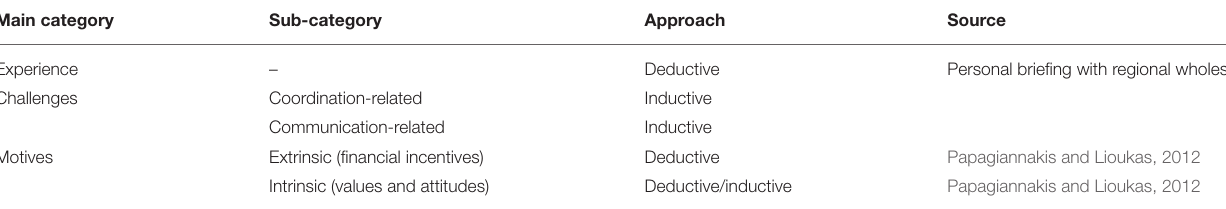
TABLE 1 | Challenges and motives for sustainable marketing structures (code